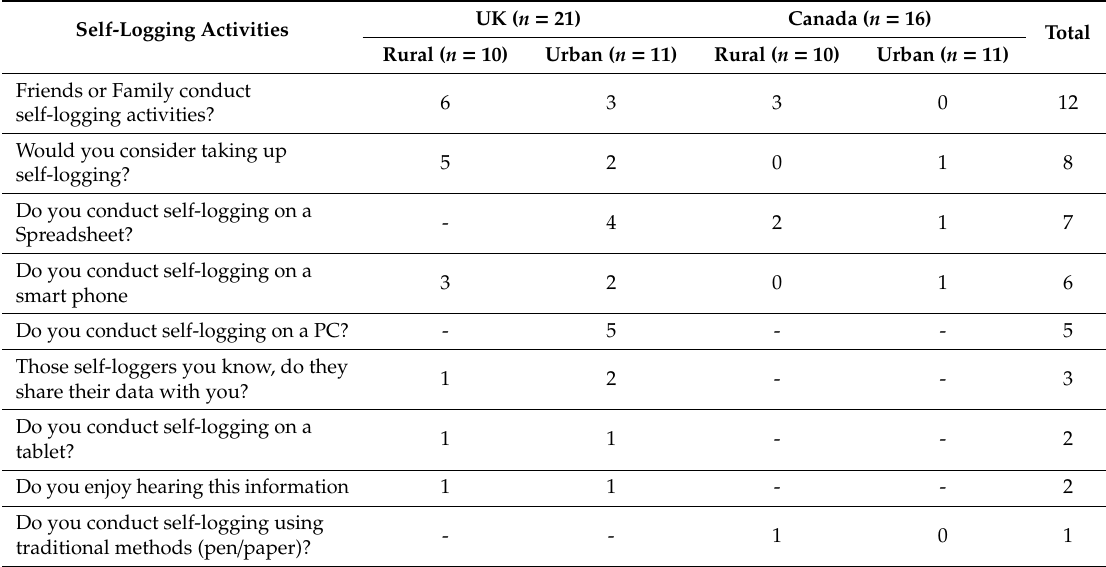
Table 8. Self-logging activities by country (UK and Canada) and location (rural and urban). Self-Logging